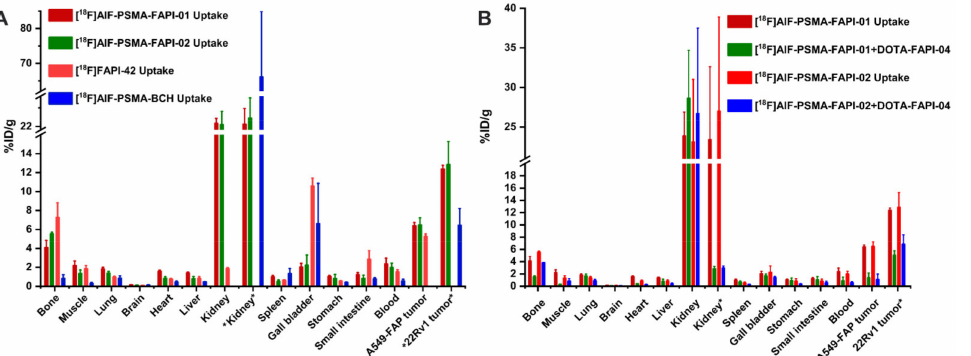
Figure 5. ( A ) Biodistribution of heterodimeric tracers [ 18 F]AlF-PSMA-FAPI-01 and [ 18 F]AlF-PSMA- FAPI-02 in A549-FAP or 22Rv1 tumor-bearing nude mice at 60 min p.i.,which compared with the corresponding monomer [ 18 F]FAPI-42 in A549-FAP tumor-bearing mice or [ 18 F]AlF-PSMA-BCH in 22Rv1 tumor-bearing mice. ( B ) Blocking experiments of [ 18 F]AlF-PSMA-FAPI-01 and [ 18 F]AlF-PSMA- FAPI-02 in A549-FAP xenografts with coinjection of DOTA-FAPI-04 inhibitor (3 mg/kg), while the kidney and 22Rv1 tumor labeled “*” are from 22Rv1 tumor-bearing mice using 2-PMPA competitor (3 mg/kg). All the data are expressed as mean ± SD (n = 4 in each group).